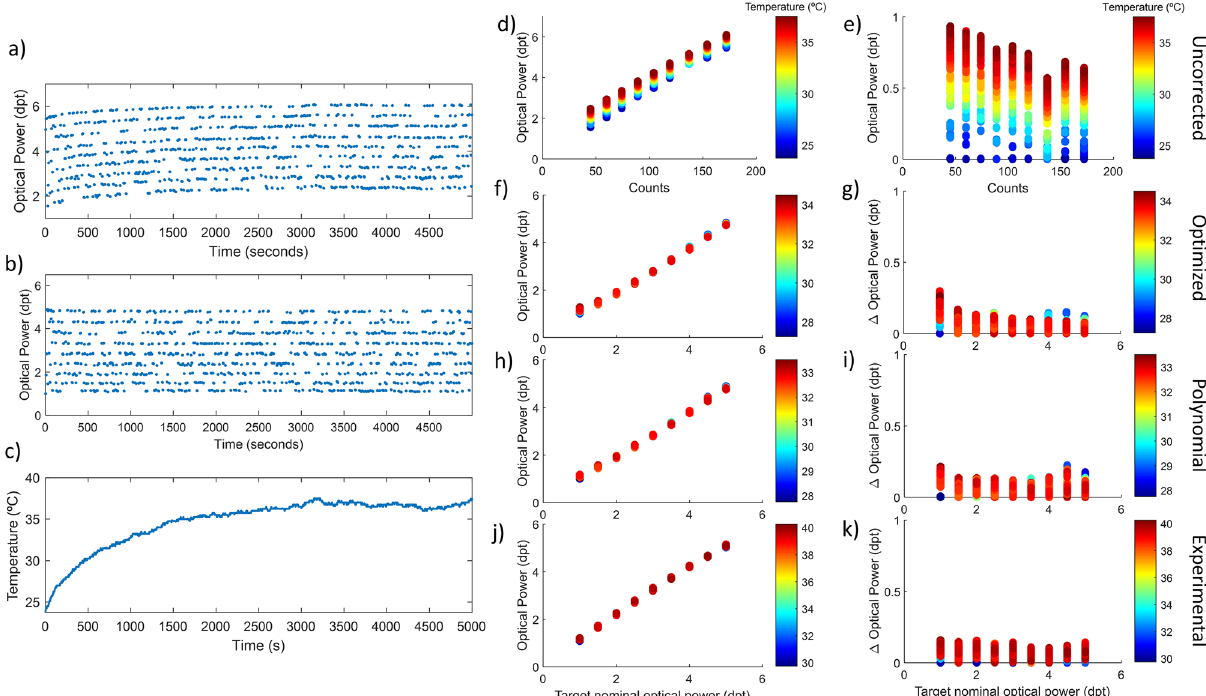
Figure 6. Random experiment description and performance of the three compensation methods used to correct temperature effect. ( a ) Optical power and temperature profile of the lens during a random sequence of power states for characterization without compensation strategy, and ( b ) with the polynomial correction for temperature compensation as an example. ( c ) Internal temperature variation and stability region. ( d,e ) Optical power measured values and deviations with respect to nominal value when no temperature correction is applied. ( f,g ) With optimized model compensation. ( h,i ) With polynomial model compensation. ( j,k ) with experimental model compensation.